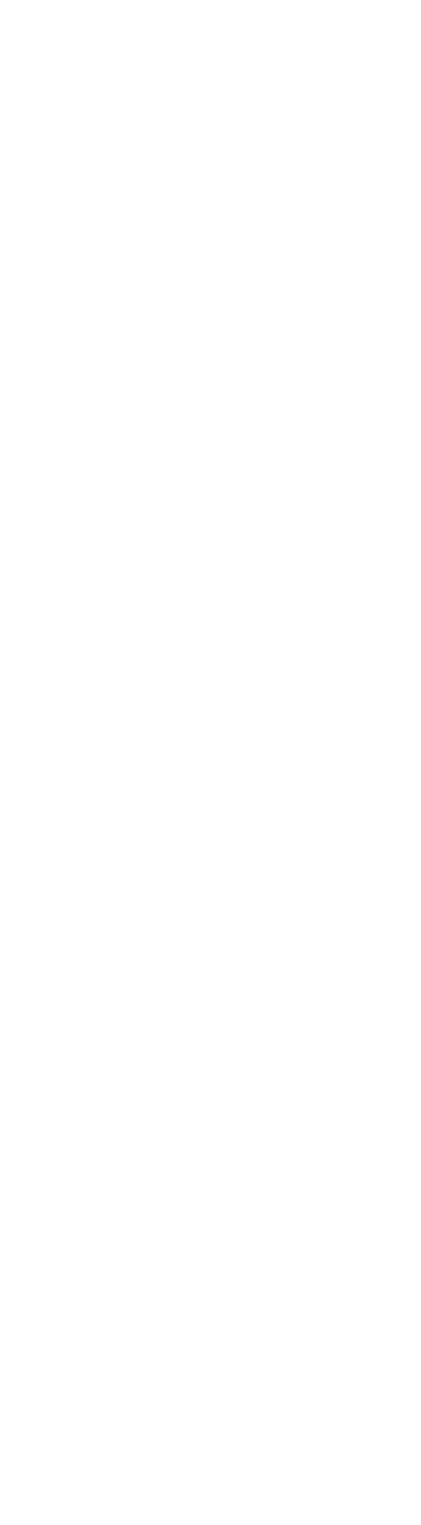
FIGURE 4 | Phylogenetic tree constructed using 16S rRNA gene sequences of LRK isolates belonging to Firmicutes phylum and their closest phylogenetic relatives. The tree was reconstructed by the Maximum Likelihood method using MEGA 6 software. Halobacterium salinarum DSM 3754 T was used as an outgroup. The numbers on the tree indicate the percentages of bootstrap sampling derived from 1,000 replications. Bar, 5 nt substitution per 100 nt. Blue triangles indicates the strains isolated in this study.